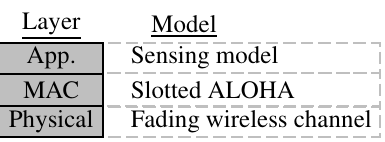
Figure 3. A layered approach to detection system modeling.